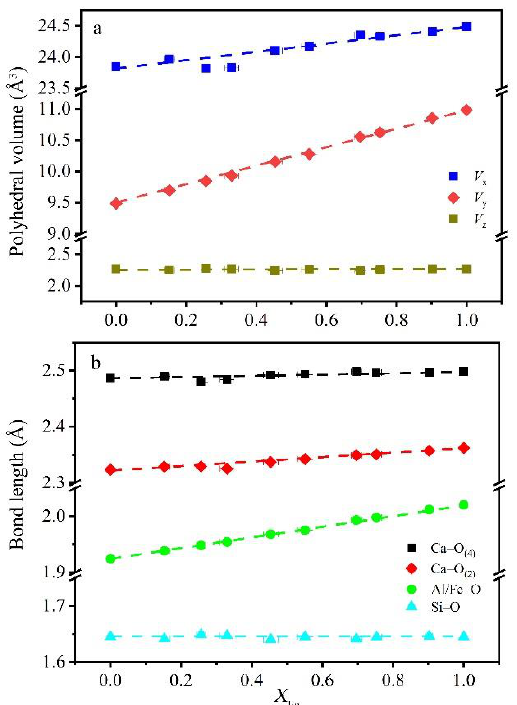
Figure 5. ( a ) Volume of polyhedra and ( b ) cation–oxygen distances at the X (dodecahedral), Y